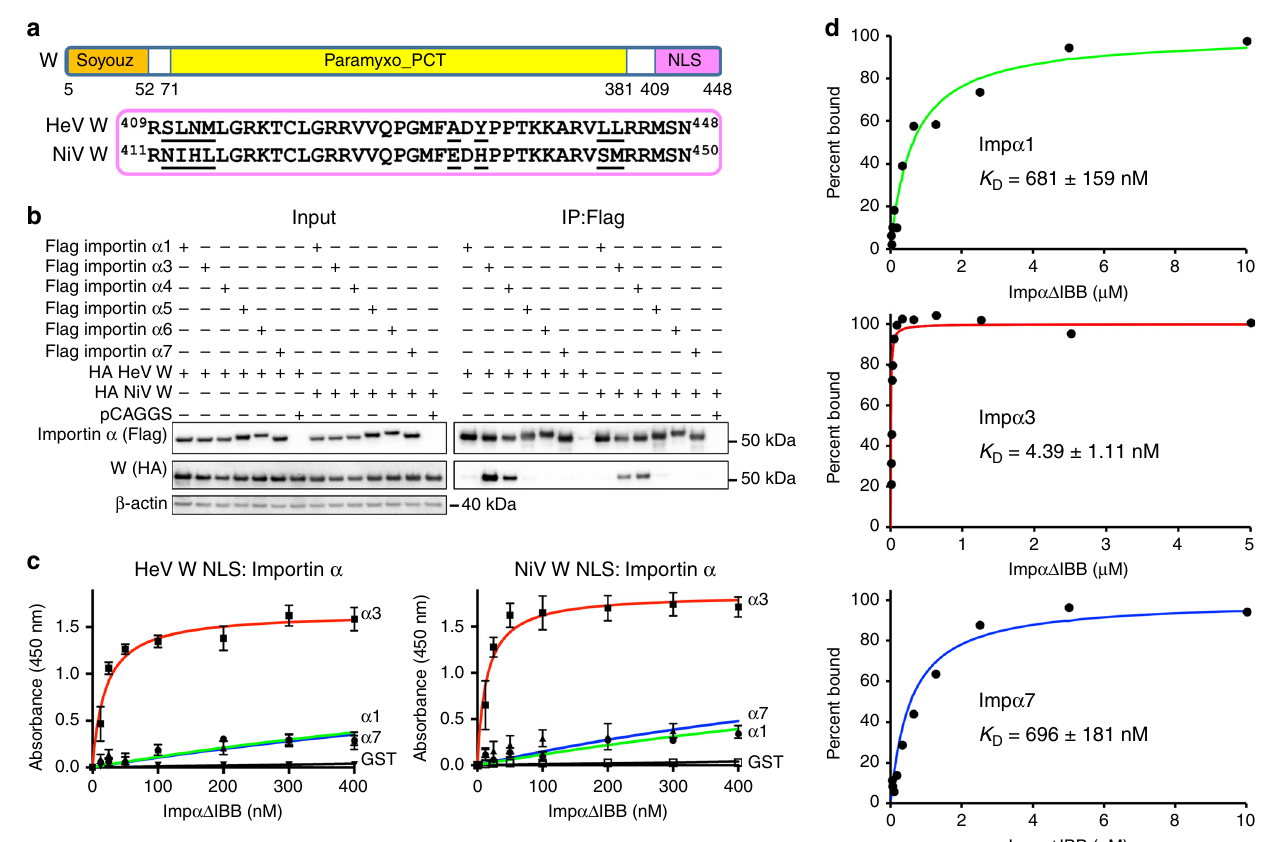
Fig. 1 Binding of Henipavirus W proteins to importins. The NLS regions of Henipavirus W proteins bind with high af fi nity and speci fi city to the importin α 2 subfamily containing importin α 3 and α 4. a The W proteins contain the Soyouz module moiety (Soyouz) and PCT disordered (Paramyxo_PCT) regions, which are conserved across paramyxovirus phosphoproteins. However, the W proteins of HeV and NiV W also possess a unique C terminus compared with other P gene products and contain an NLS that mediates translocation of W into the nucleus. b HeV W and NiV W interact with importin α 3 and α 4. Co-immunoprecipitation assay performed with Flag antibody on lysates of HEK293T cells expressing Flag-tagged importin α 1, α 3, α 4, α 5, α 6, α 7 and HA- tagged full length HeV W and NiV W, as indicated. Western blots were performed for HA and Flag. WCL, whole cell lysate; IP, immunoprecipitation. pCAGGS denotes empty vector control. c The NLS region of HeV W and NiV W interact with high af fi nity to importin α 3. An ELISA was performed using GST-W (GST as a negative control) proteins coated on 96-well plates, and binding of 6xHis-tagged importin α 1, α 3, α 7 assessed using an anti-6xHis HRP antibody. Error bars show the S.E.M for three replicates. d MST assay con fi rms high af fi nity binding of importin α 3 to the NLS region of NiV W proteins, and comparatively lower af fi nity binding to importin α 1 and α